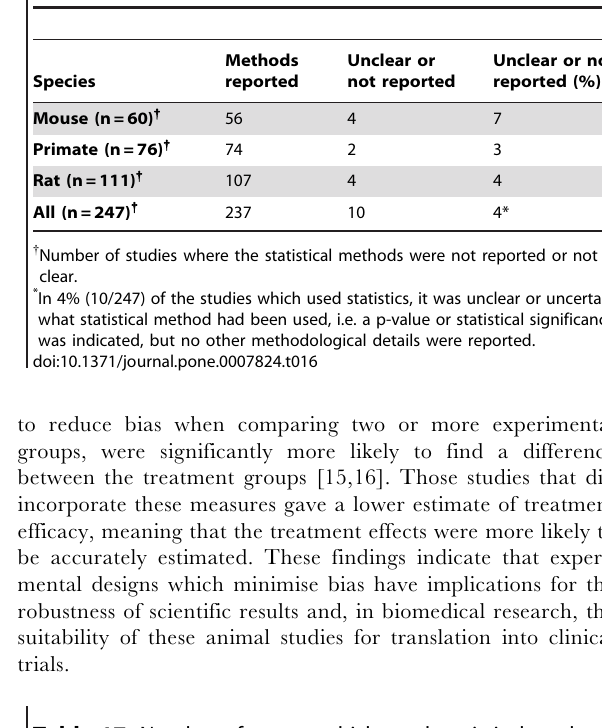
Table 15. Number of studies using a factorial design.